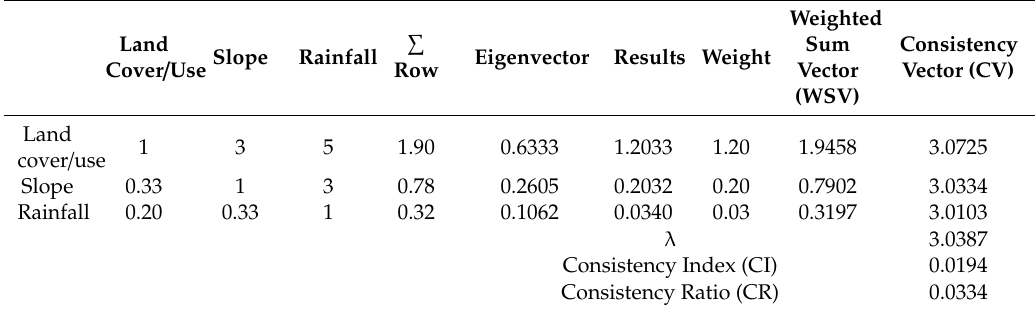
Table 3. Analytic hierarchy process (AHP) judgment matrix of the CFR-new-a ff ecting parameters and consistency ratio assessment.